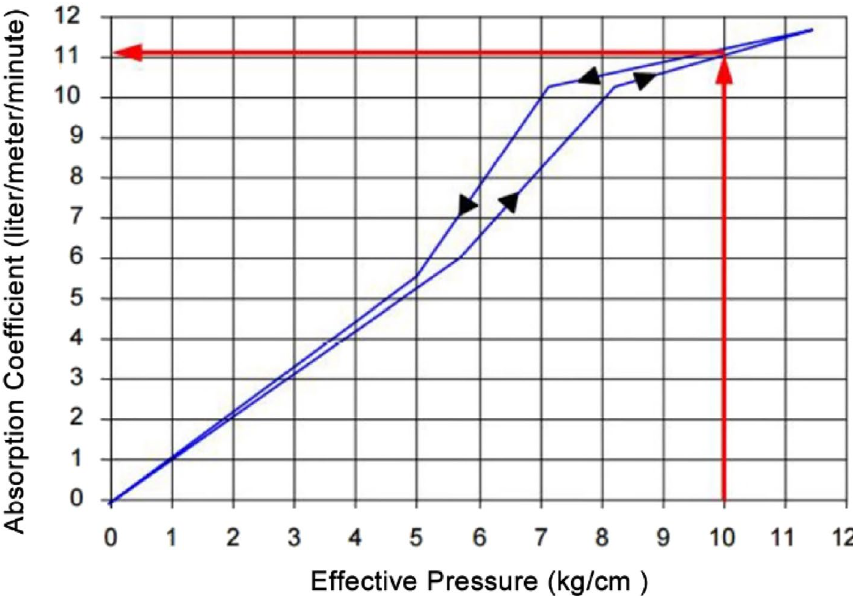
Fig. 6 Determination of Lugeon value in SK-36 borehole by graphical method